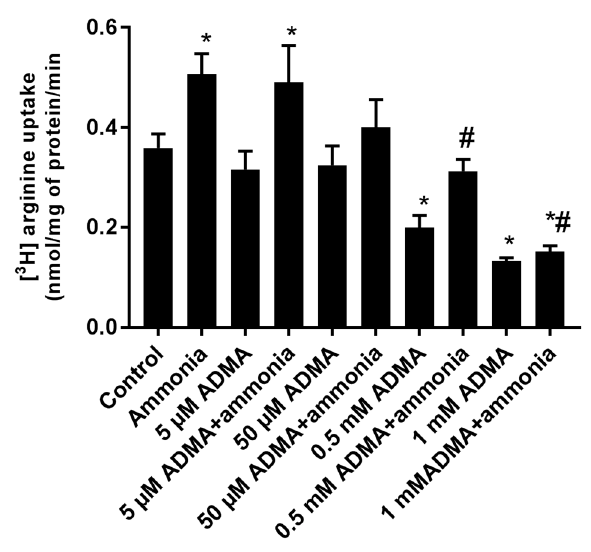
Figure 5. The effect of ADMA on [ 3 H]arginine uptake in control and 5 mM ammonia treated primary astrocytes cultures. Result are mean ± SD; n = 6, * p < 0.01vs control, # p < 0.01 vs. ammonia.